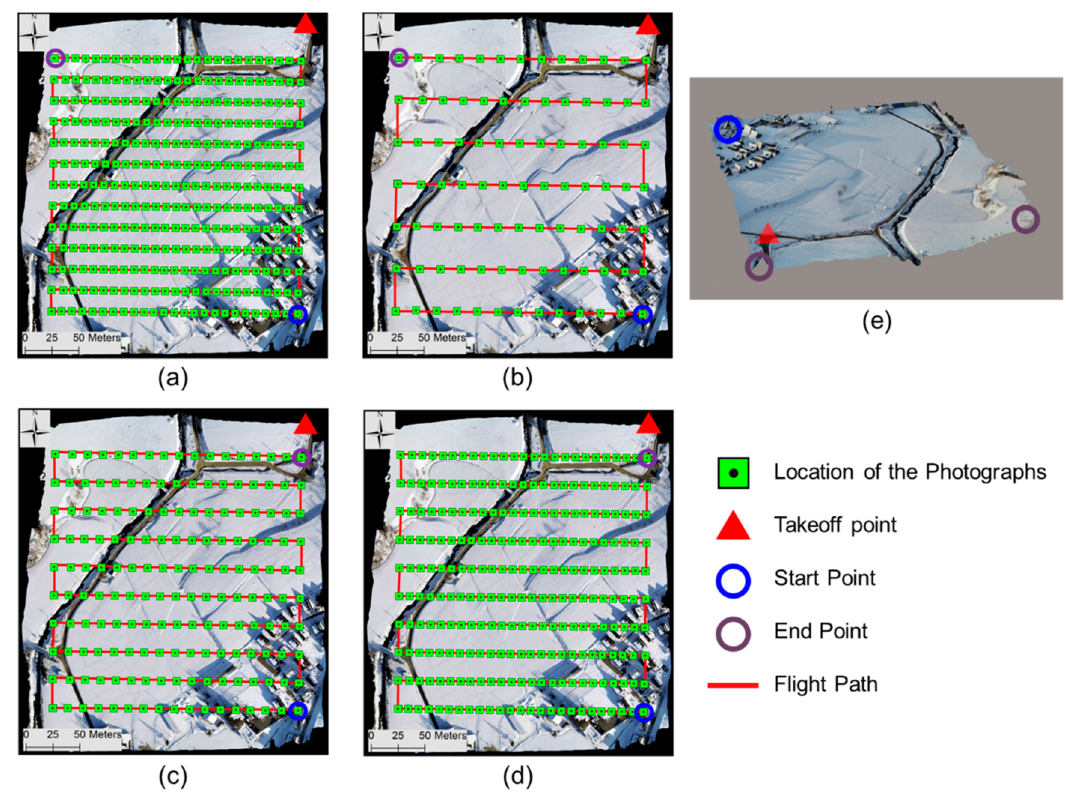
Figure 5. Flight path and location of photo according to each method: ( a ) 50 m, 80%; ( b ) 100 m, 80%; ( c ) 50 m, 70%; ( d ) 100 m, 90%, respectively. ( e ) Three-dimensional view of the study area viewed from the take-off